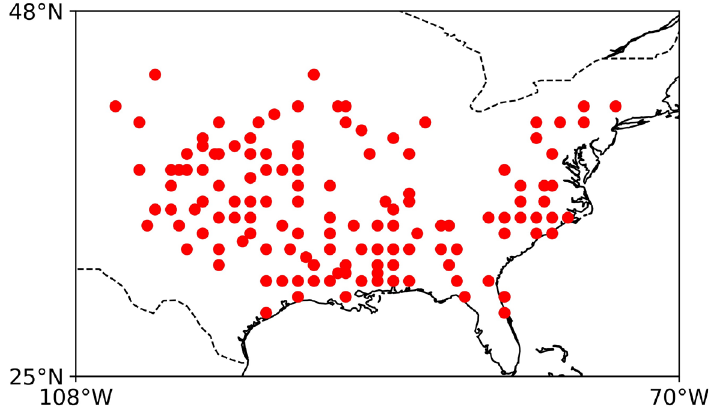
Figure 1. Location of selected storm events.